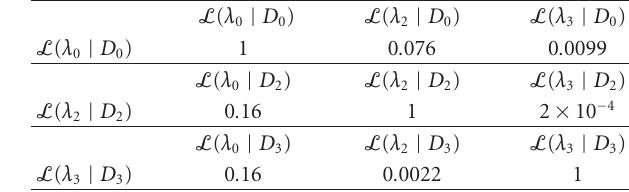
Table 5: Cosmological parameters ( Λ CDM + sz + lens). Table 6: The likelihood ratio: Λ CDM + sz +